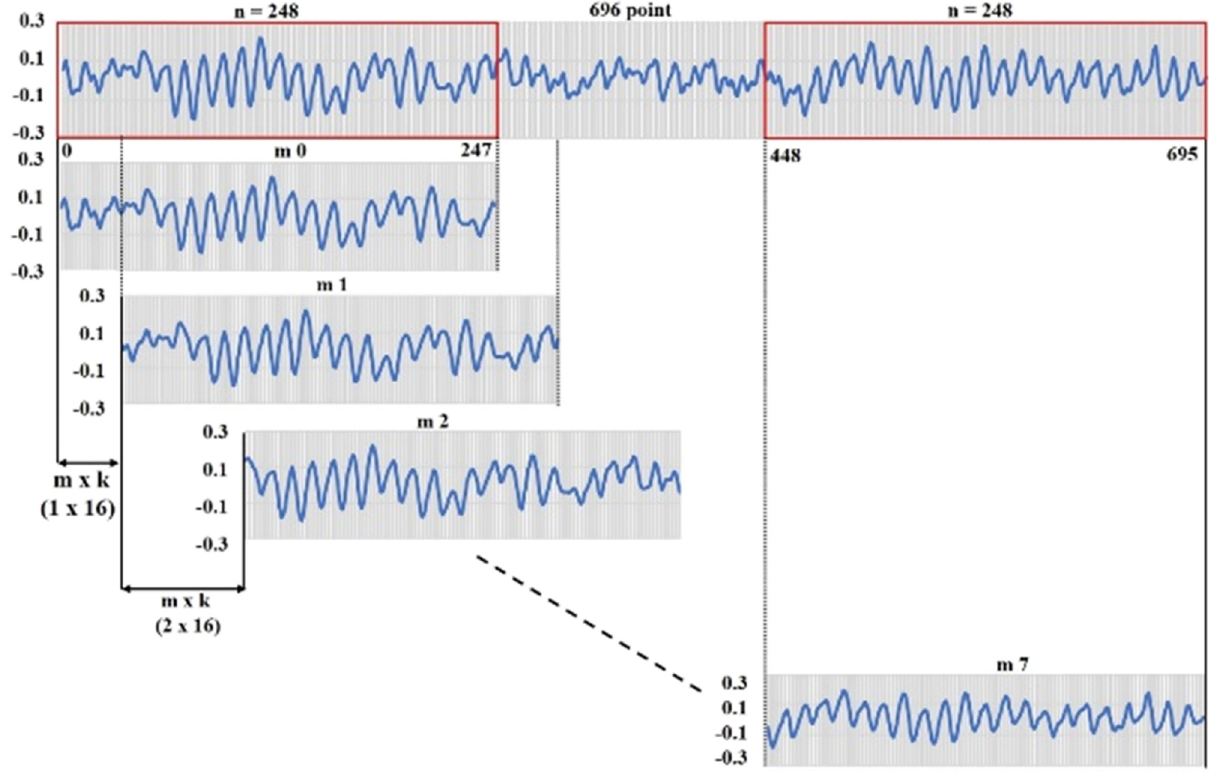
Figure 10: Dislocated